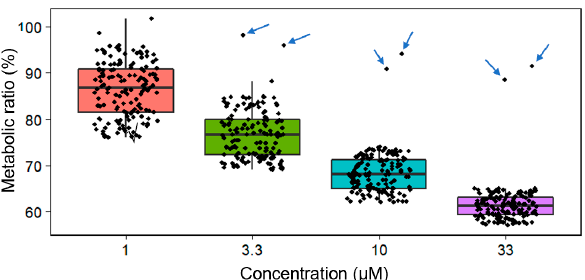
Figure 6. The metabolic ratio distribution of single HCC827 cells treated with crizotinib at different concentrations. Single cells ( n = 150) were analyzed in each treatment. Some cells exhibited extreme metabolic ratios that were numerically distant from the rest of the data; these are marked with arrows.